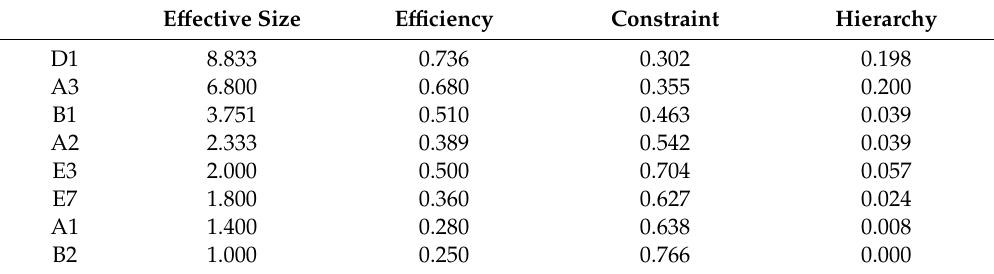
Table 4. Measurement Values of the Structural